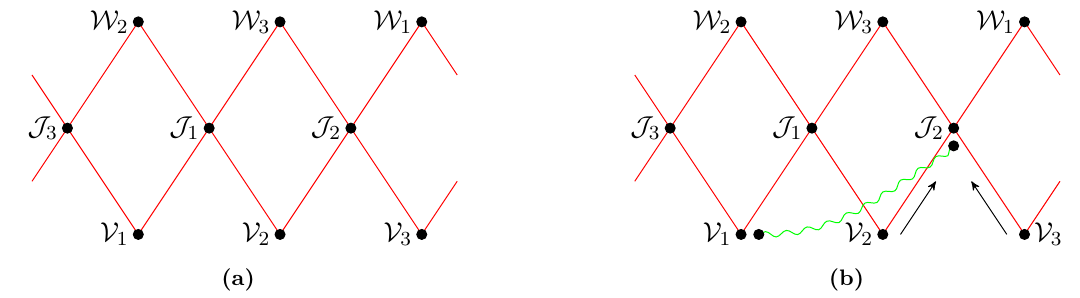
Figure 21. (a) The boundary causal structure for n = 3 . Signals from any two input regions meet at intermediate regions and scatter to two output regions. (b) We exploit a resource state which has the property that systems from V is consistent with the condition that I ( V